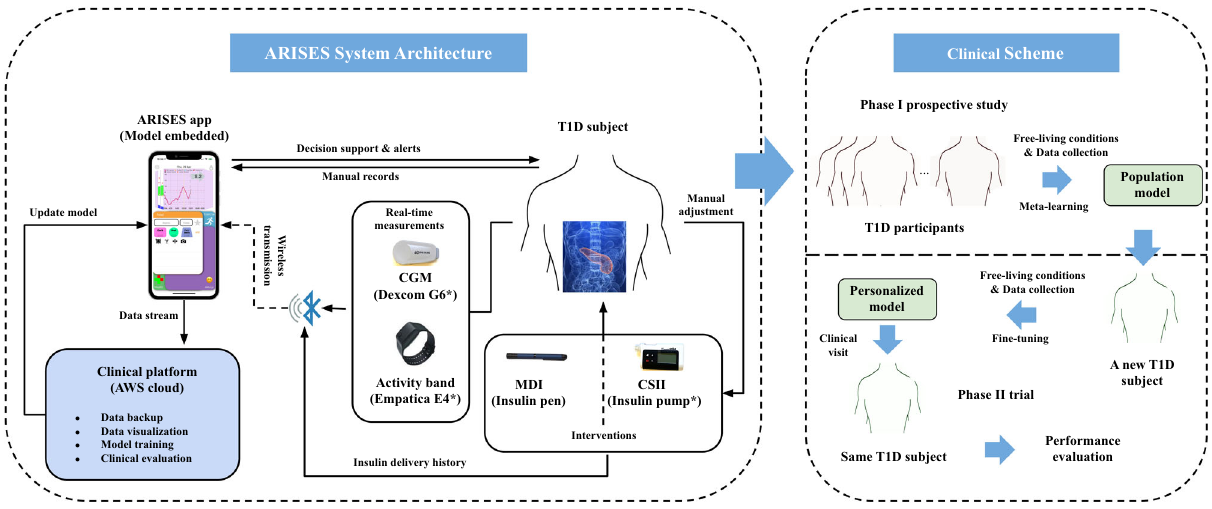
Fig. 1 System architecture and clinical scheme of ARISES. A T1D subject is equipped with CGM and the wristband to measure glucose levels and vital signs, both of which communicate with the ARISES app via Bluetooth connectivity and provide input data for the deep learning models. The wearable devices in the system are marked by *. The data collected in phase I are used to train a population model with meta- learning, which is then fi ne-tuned in phase II to develop personalized models.